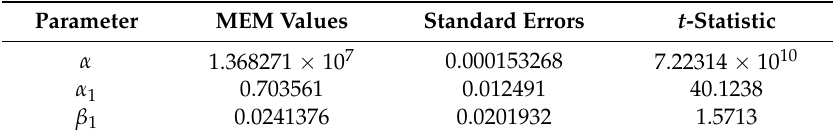
Figure 11. Forecast for years 2013–2016 with and without incorporating fat-tails. Table 2. Multiplicative Error Model Parameters.